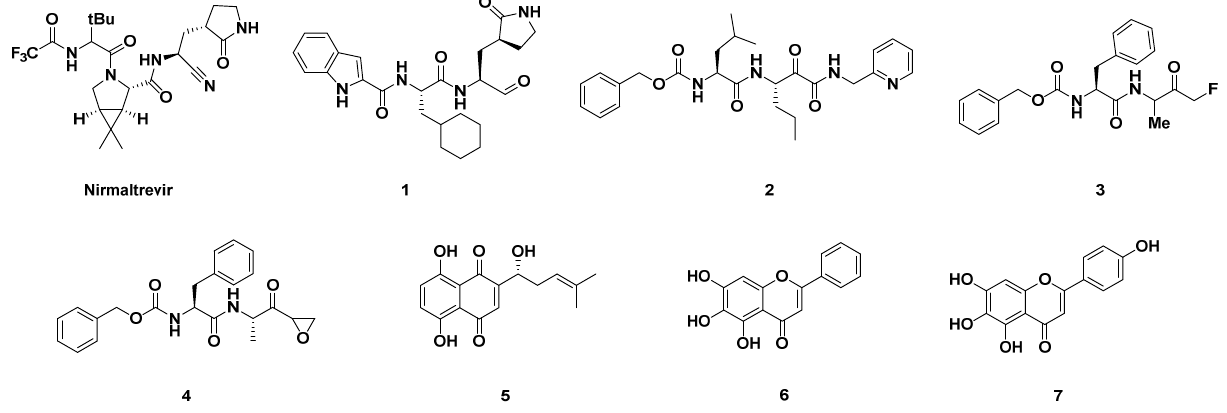
Figure 1. Examples of different chemical classes of SARS ‐ CoV ‐ 2 M pro inhibitors. A covalent mechanism of action was observed for M pro inhibitors bearing electrophilic fragments, such as aldehydes ( 1 ), α‐ ketoamides ( 2 ), fluoromethyl ketones ( 3 ), and epoxyketones ( 4 ). A non ‐ covalent inhibition of M pro was reported for 5 , 6 and 7 .